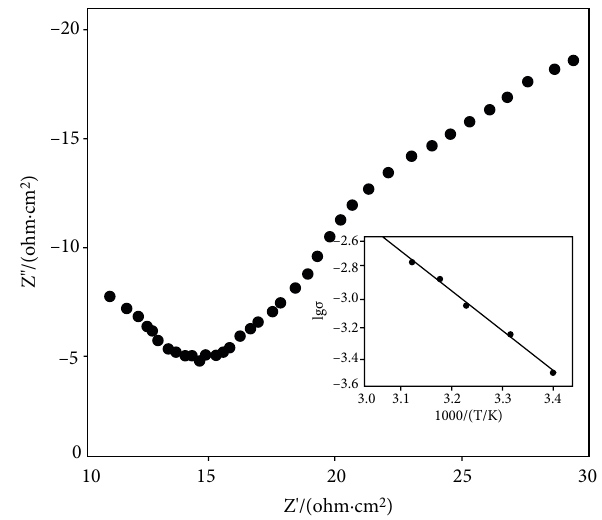
Figure 6: Electrochemical impedance spectrum of NiZrMo. Inset: arrhenius plot of conductivity for